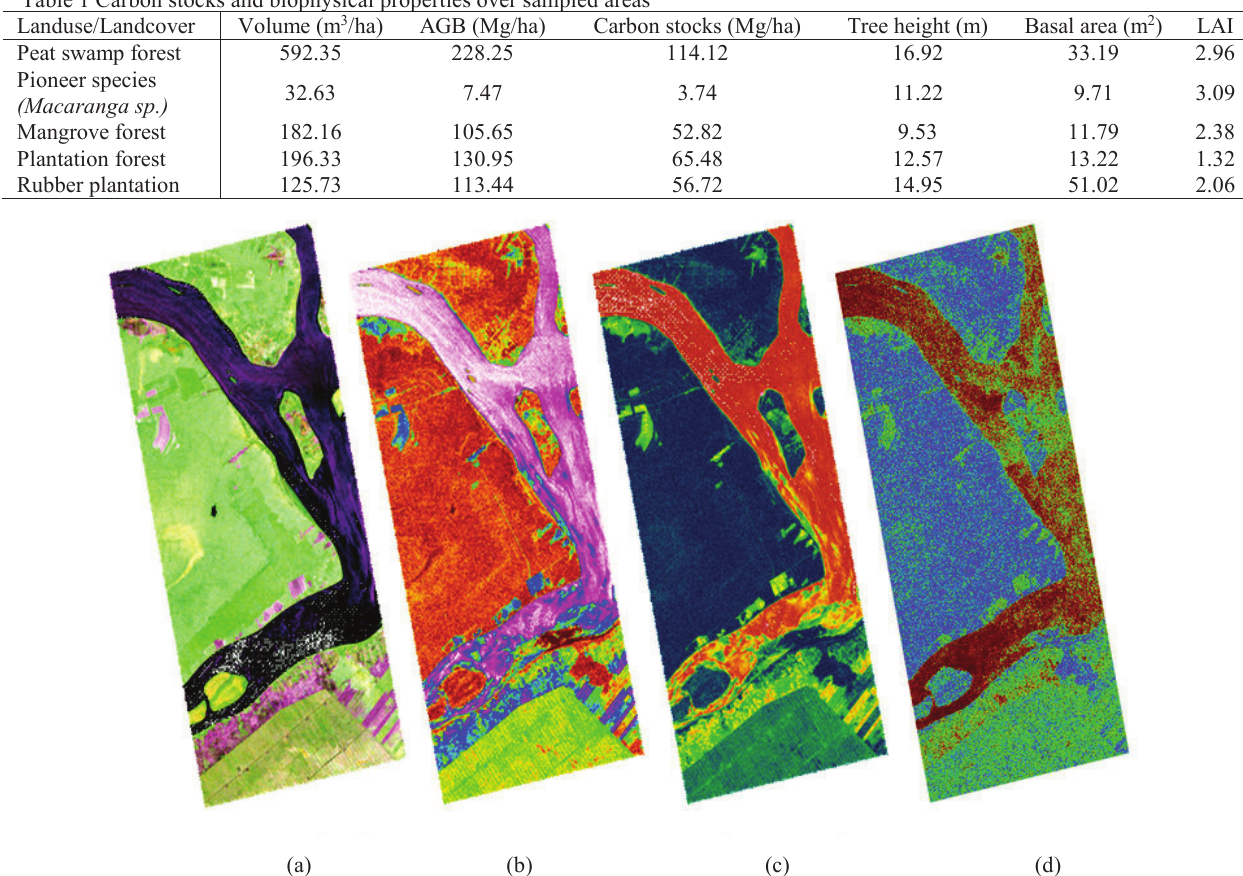
Figure 2 RGB composite of HH, HV, VV (a), polarimetric alpha (b), polarimetric entropy (c) and polarimetric anisotropy (d)